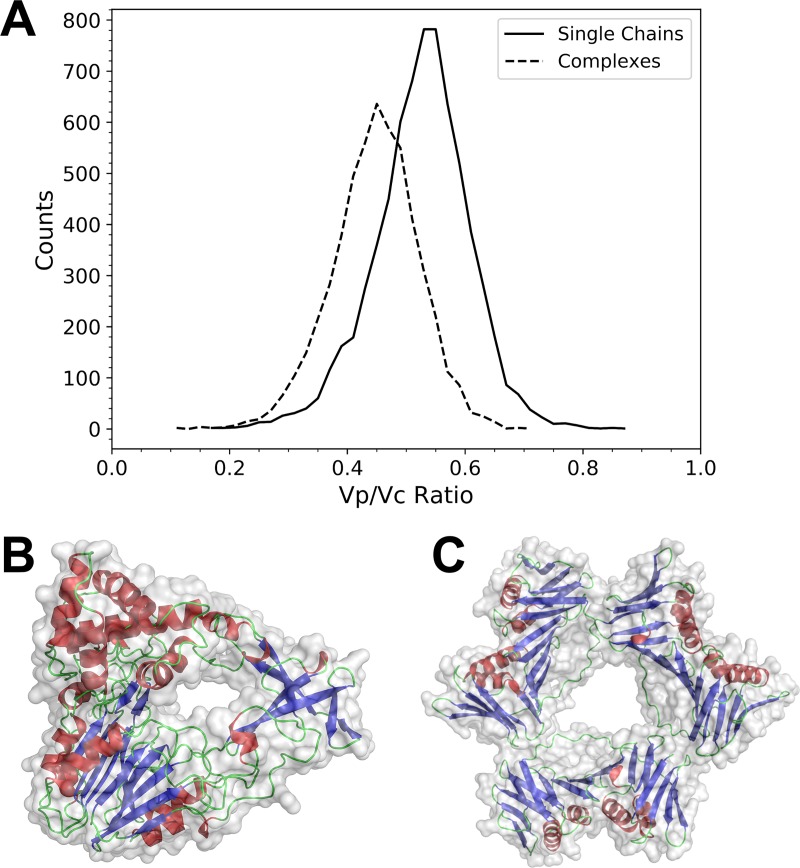
Protein structures with holes.(A) The distribution of the ratio of the protein volume (Vp) to the volume of its convex hull (Vc). Solid line, the single-chain dataset; and dashed line for the complex structure dataset. (B) glutaryl-7-aminocephalosporanic acid acylase b-chain (PDB ID: 4hst-B). The Vp/Vc Ratio is 0.408. (C) Active proliferating cell nuclear antigens (PCNAs), trimer (3lx1). The Vp/Vc ratio is 0.399.